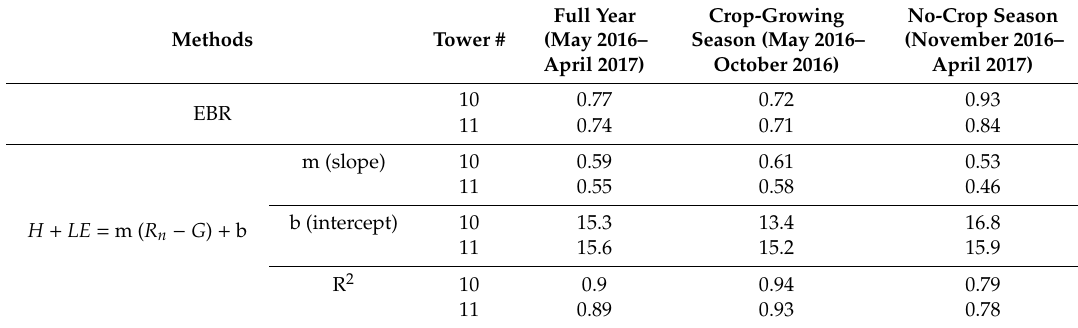
Table 1. Energy balance ratio (EBR) and slopes and intercepts from the relationship between H + LE and R n − G .